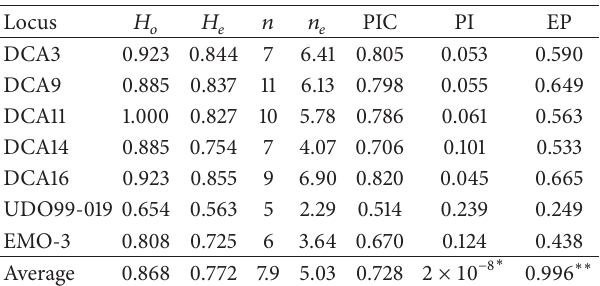
Table 2: Parameters of genetic variability of each microsatel- lites locus obtained among parental population (pollen donors). Observed ( 𝐻 𝑜 ) and expected ( 𝐻 𝑒 ) heterozygosity, number of alleles ( 𝑛 ), effective number of alleles ( 𝑛 𝑒 ), polymorphic information content (PIC), probability of identity (PI), and exclusion probability (EP).